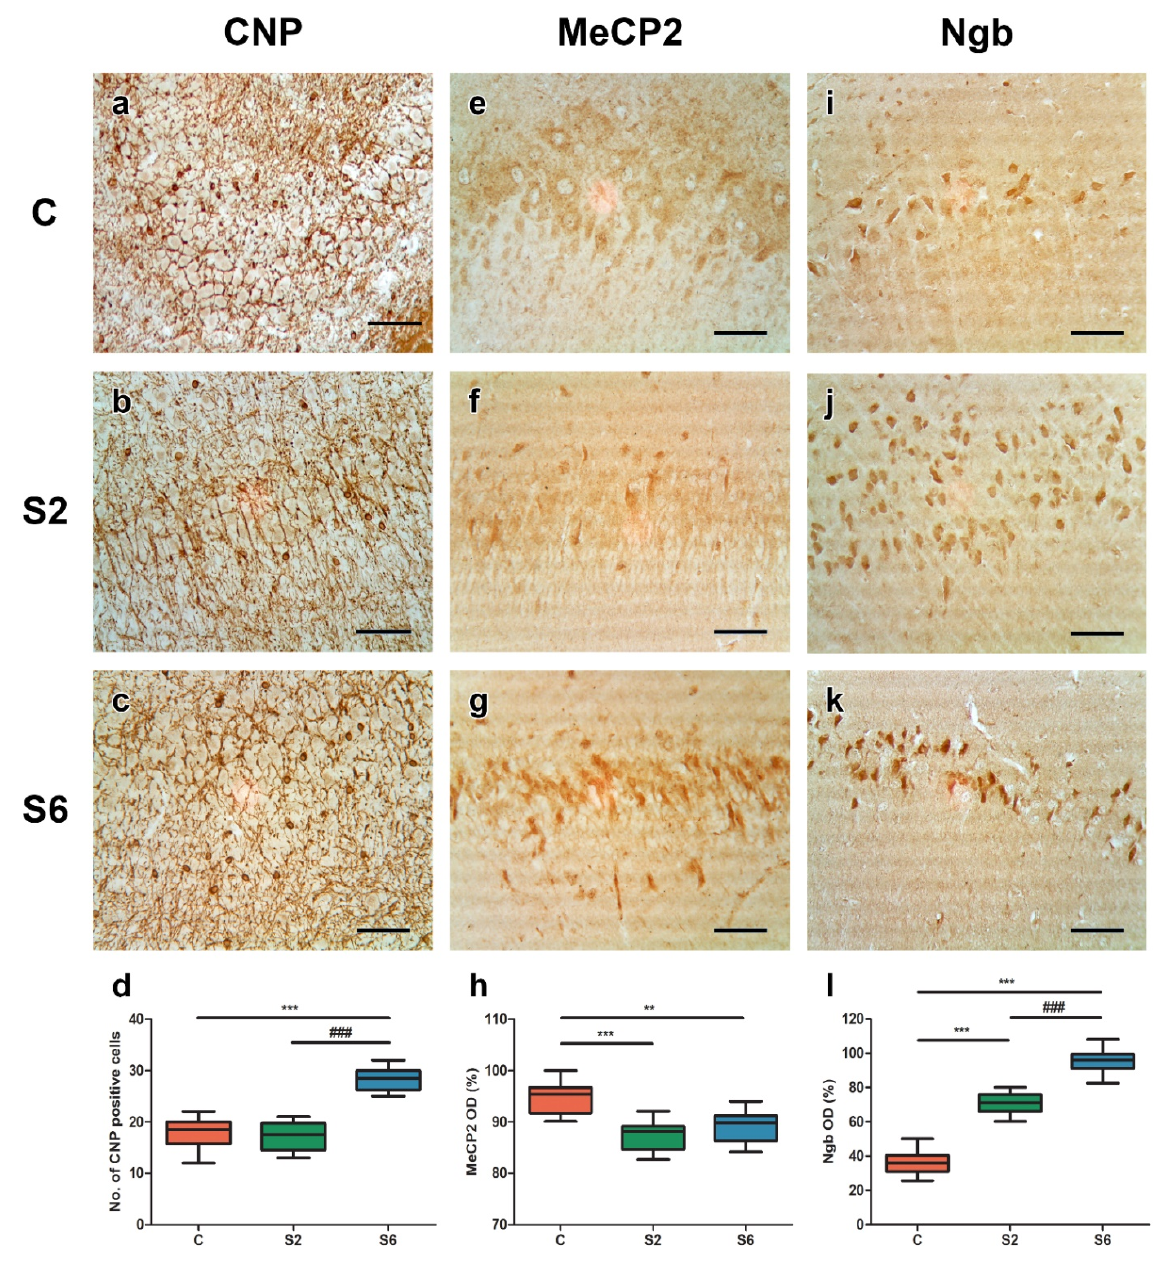
Figure 5. Immunohistochemical stain of rat hippocampus in the Control and stress-exposed animals; ( a – d ) Immunodetection of oligodendrocytes using CNP antibody (2 (cid:48) -3 (cid:48) -cyclic-nucleotide 3 (cid:48) -phoshodiesterase) revealed the significant oligodendrocytes proliferation after 6 days of repetitive stress ( p < 0.001 compared to Control and S2 group); ( e – h ) MeCP2 immunoreactions decreased after repetitive stress exposure compared to Control ( p < 0.01 for S6; p < 0.001 for S2); ( i – l ) Neuroglobin (Ngb) expression in CA3 neurons in the Control and stressed animals. The repetitive stress exposure significantly increased/stabilized Ngb expression compared to the Control ( p < 0.001) or 2 vs. 6 days of stress ( p < 0.001). The bottom and top of the box are the first and third quartiles and the whiskers above and below the box indicate the 95th and 5th percentiles. The median is indicated as a hori- zontal line. Statistical significance between S2 and S6 was noted with # (### p < 0.001), whereas the comparison to Control was annotated with (** p < 0.01; *** p < 0.001). The scale bar for ( a – k ) figures is 20 µ m, magnification ×